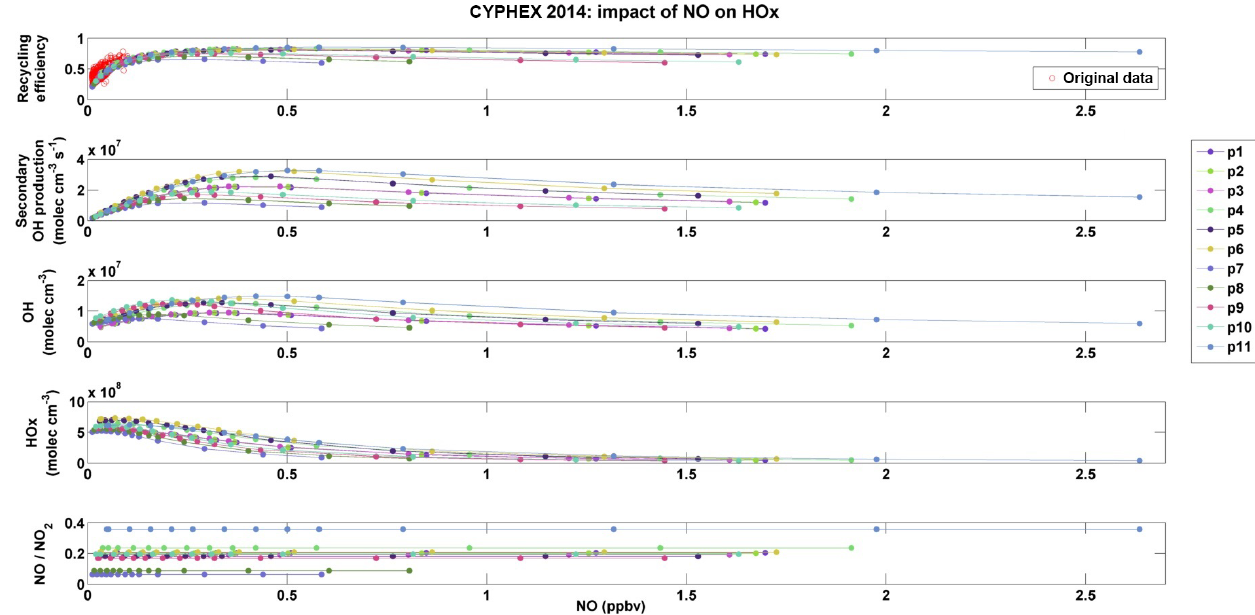
Figure 8. Sensitivity of recycling efficiency, secondary OH production, OH, and HO x to changes in NO x levels. P1–P11 are different starting points derived from the original dataset, for which NO x is increased to 3ppbv, while maintaining the original NO − NO 2